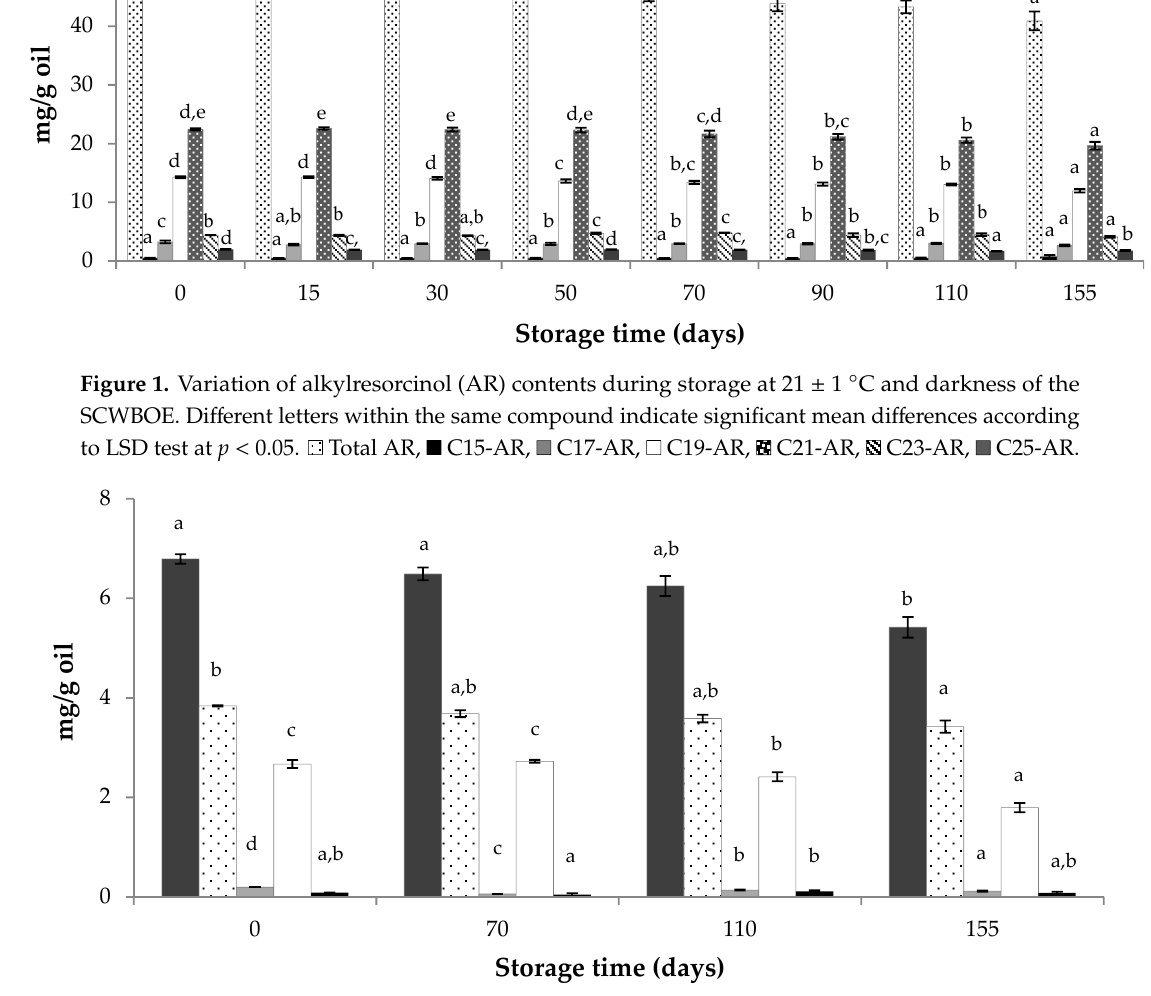
Figure 2. Changes of tocopherol levels during storage at 21 ± 1 ◦ C and darkness of the SCWBOE. Di ff erent letters within the same compound indicate significant mean di ff erences according to LSD test at p < 0.05. Total tocopherol, α -tocopherol, ‐ tocopherol, ‐ tocopherol, ‐ tocopherol.